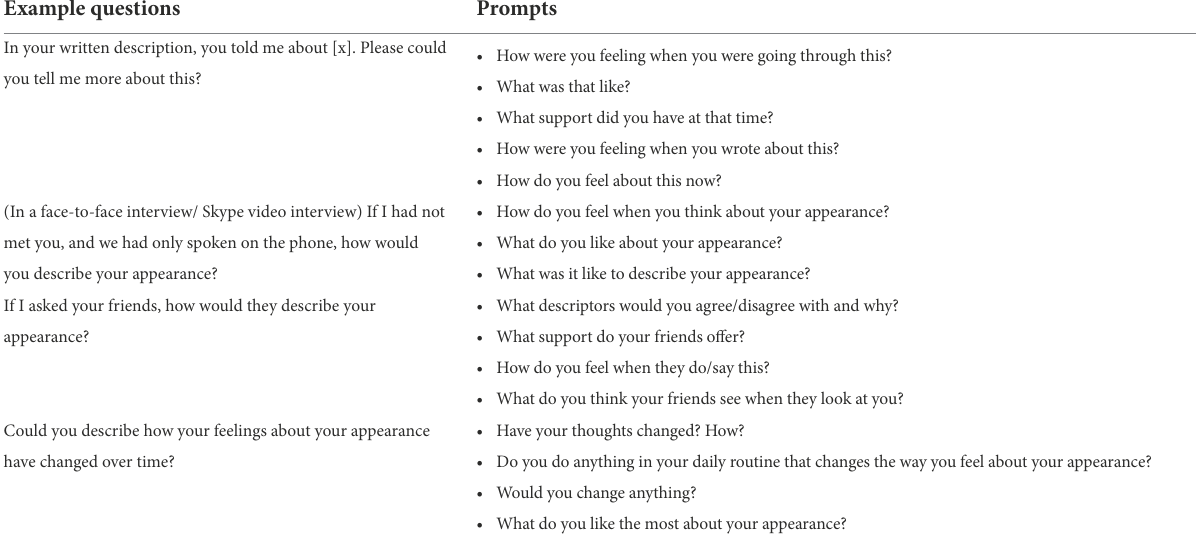
TABLE 2 Indicative interview topic